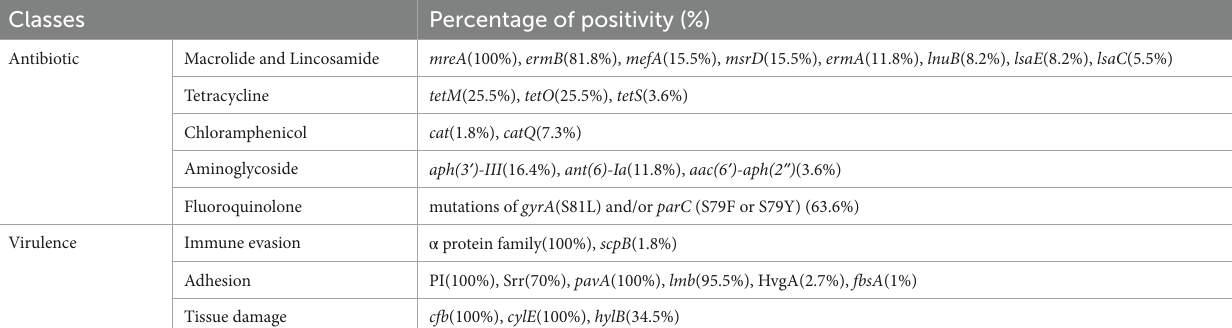
TABLE 2 Antibiotic resistance genes or mutations and virulence factors in 110 clindamycin-resistant Streptococcus agalactiae strains.